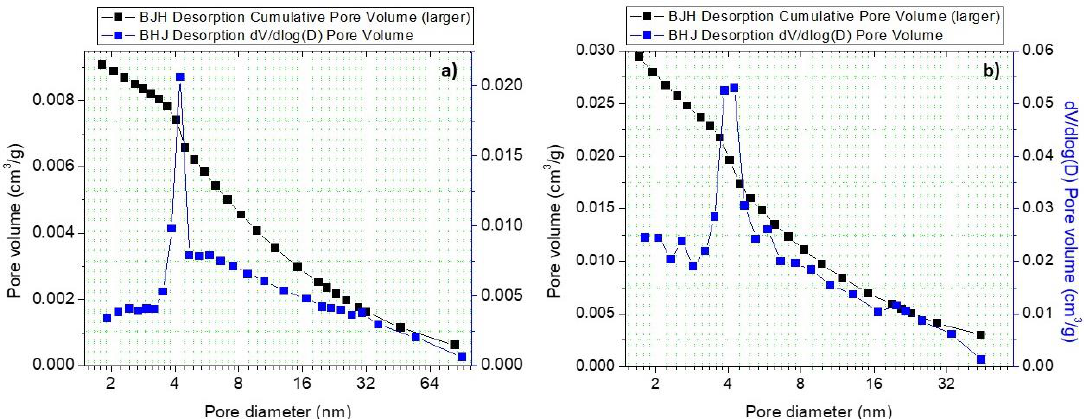
Figure 6. Pore size distribution of ( a ) NTO/Ni/Pt and ( b ) NTO/Pt/Ni samples.